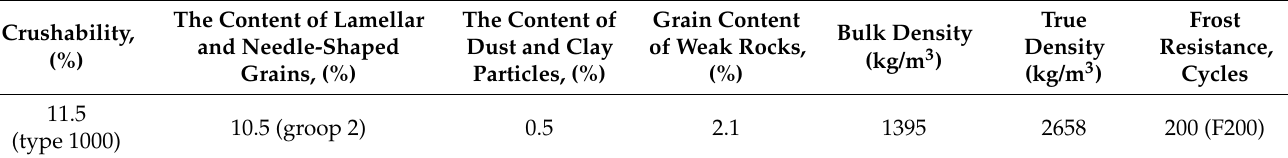
Table 2. Physical and mechanical properties of crushed stone.